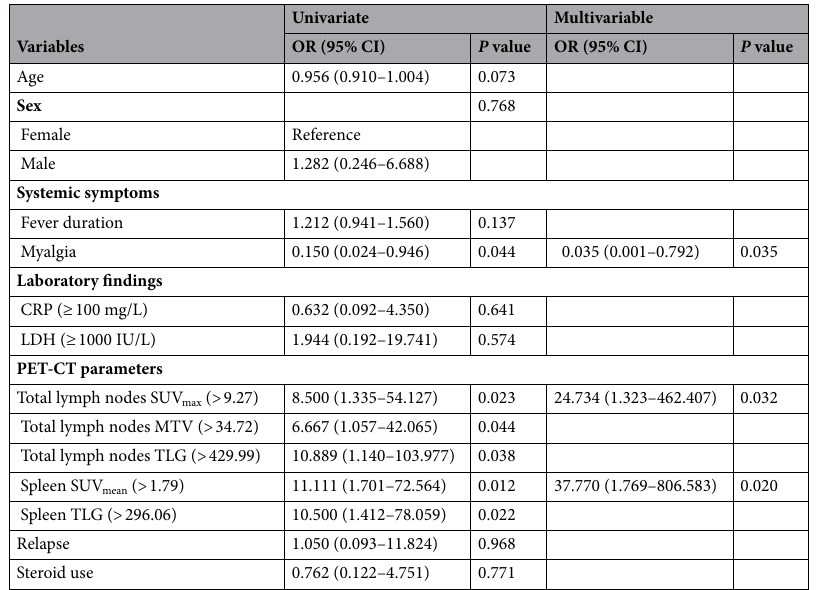
Table 3. Factors associated with severe Kikuchi-Fujimoto disease using logistic regression model. OR, Odds ratio; CI, confidential interval; SUV max , maximum standardized uptake value; SUV mean , mean standardized uptake value; MTV, metabolic tumor volume; TLG, total lesion glycolysis; CRP, C-reactive protein; LDH, lactate